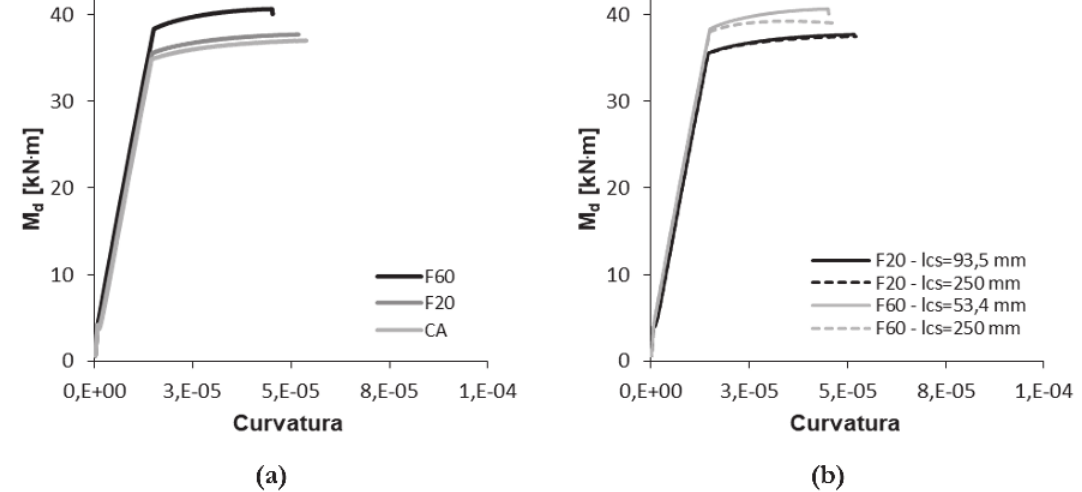
Figura 14 Relação momento-curvatura: a) F20 com l b) comparação dos resultados com diferentes valores de l